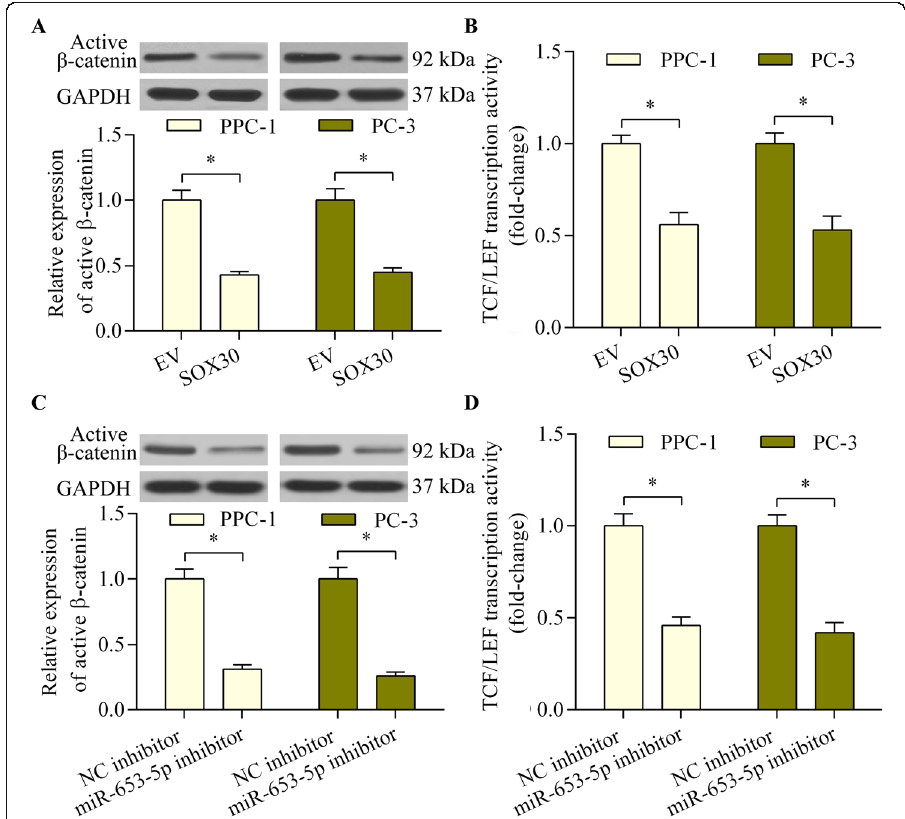
Fig. 5 SOX30 inhibited the activation of Wnt/ β -catenin signaling in prostate cancer cells. a The effect of SOX30 overexpression on active β -catenin expression was determined using western blotting. PPC-1 and PC-3 cells were transfected with SOX30 expression vector and incubated for 48 h. b The effect of SOX30 overexpression on Wnt/ β -catenin signaling was assessed with a TCF/LEF luciferase reporter assay. PPC-1 and PC-3 cells were co-transfected with SOX30 expression vector and TCF/LEF luciferase reporter vector and incubated for 48 h. c The effect of miR-653-5p inhibition on active β -catenin expression was measured using western blotting. PPC-1 and PC-3 cells were transfected with miR-653-5p inhibitor or NC inhibitor and incubated for 48 h. d The effect of miR-653-5p inhibition on Wnt/ β -catenin signaling was assessed with a TCF/LEF luciferase reporter assay. PPC-1 and PC-3 cells were co-transfected with TCF/LEF luciferase reporter vector and miR-653-5p inhibitor or NC inhibitor and incubated for 48 h ( n = 5, * p <